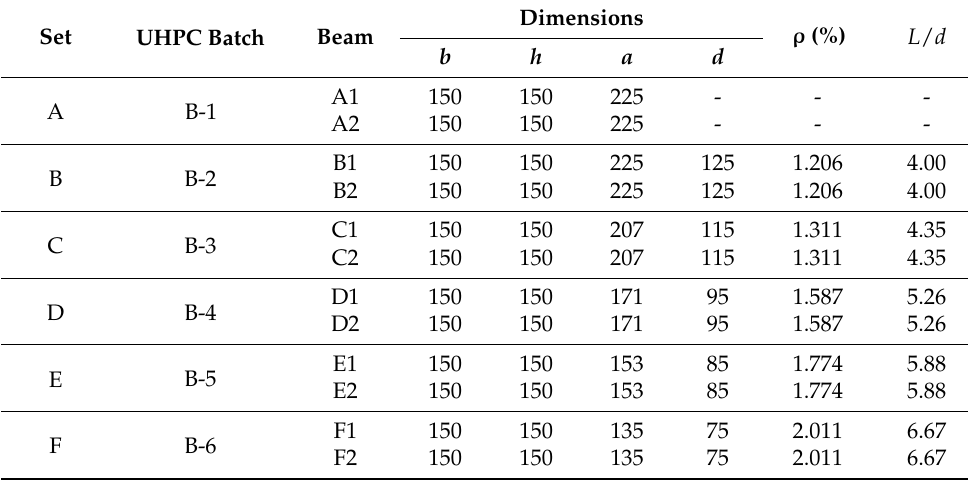
Table 6. Reinforcement details for beam